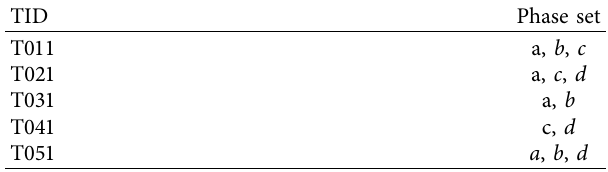
Table 1: Transaction database D .